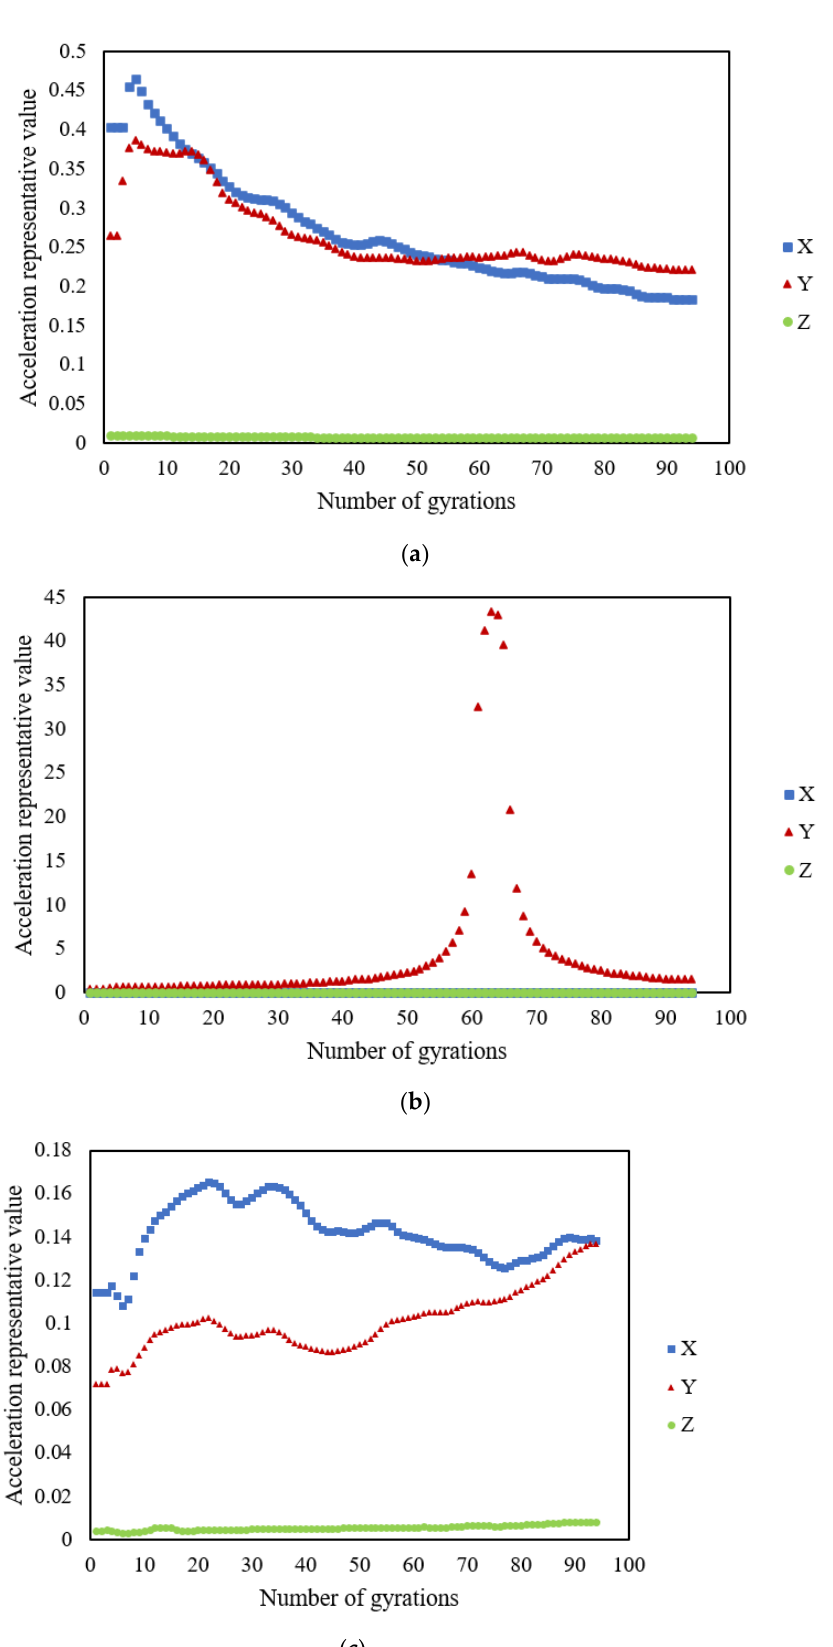
Figure 14. Representative acceleration value with different compaction temperatures: ( a ) 160 °C, ( b ) 170 °C, and ( c ) 180 °C.